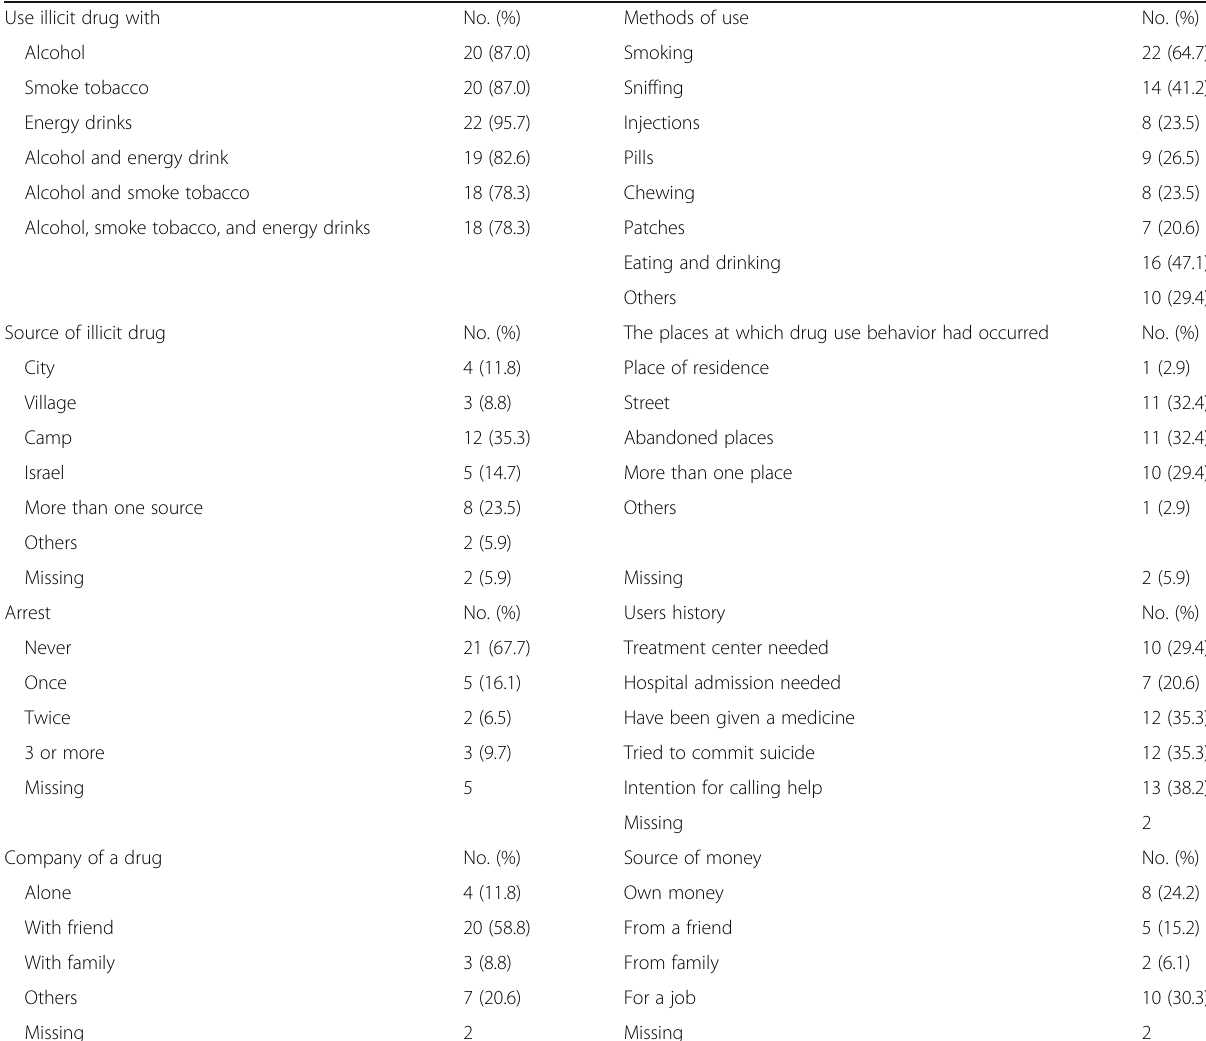
Table 4 Pattern of illicit drug use among users Use illicit drug with No. (%) Methods of use Alcohol